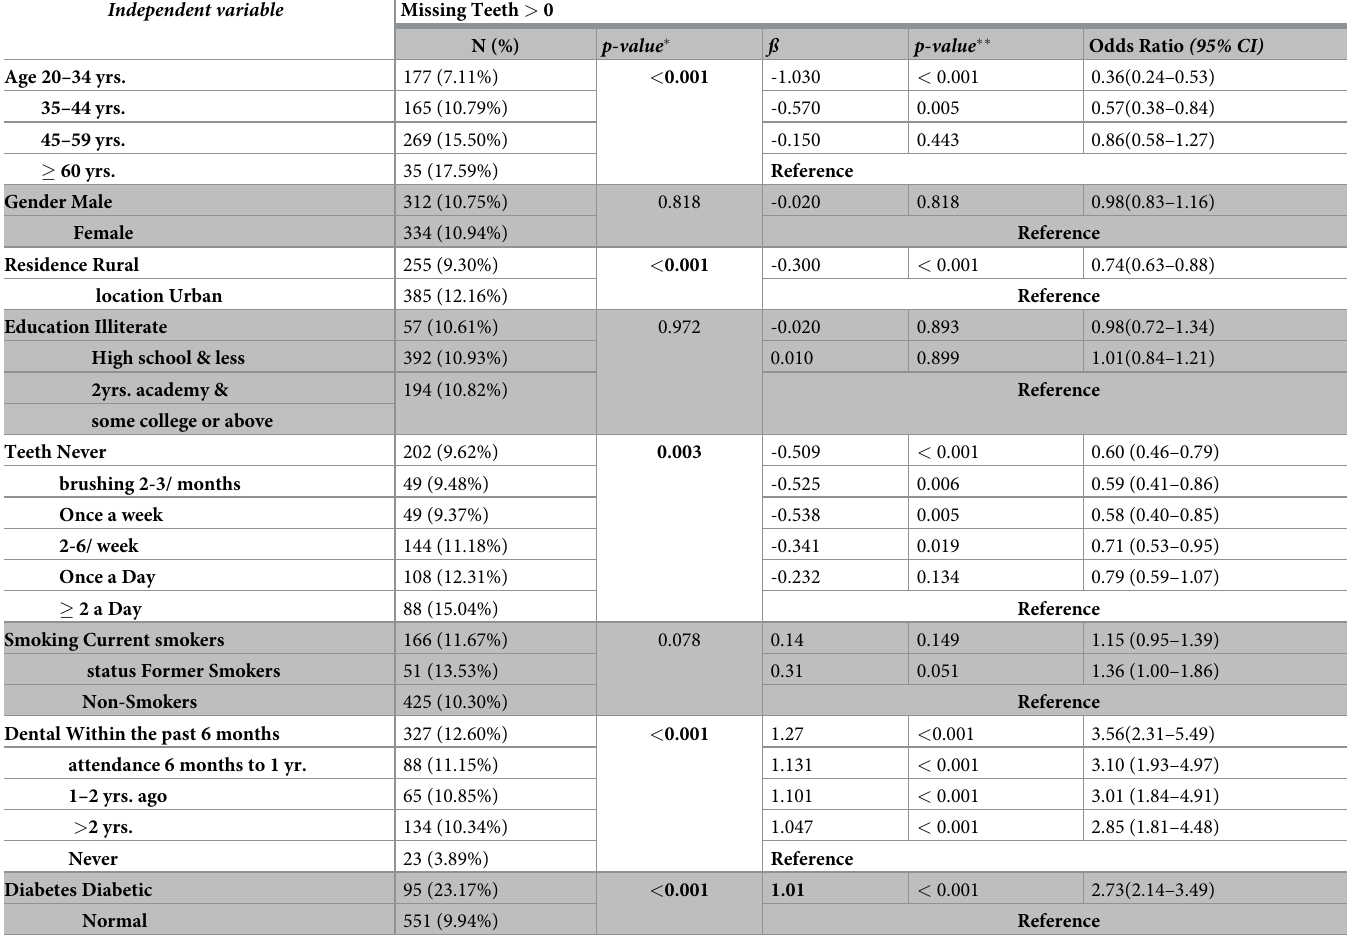
Table 3. Logistic regression analysis showing the associations between tooth loss and potential risk factors.